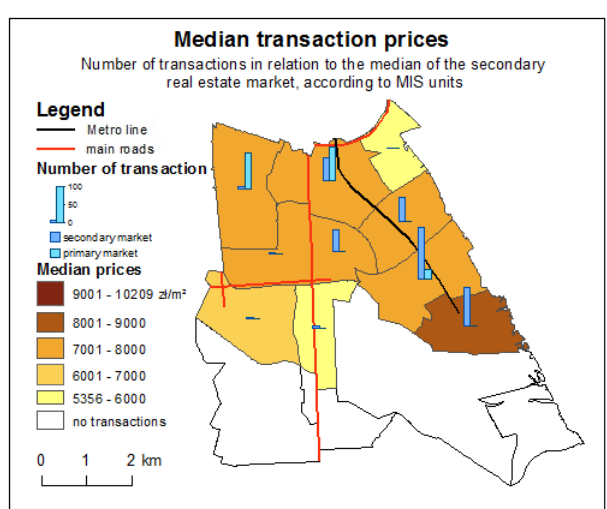
Fig. 11. Number of transactions on the primary and secondary residential real estate markets in Ursynów in relation to the median of the secondary real estate market, according to MIS units